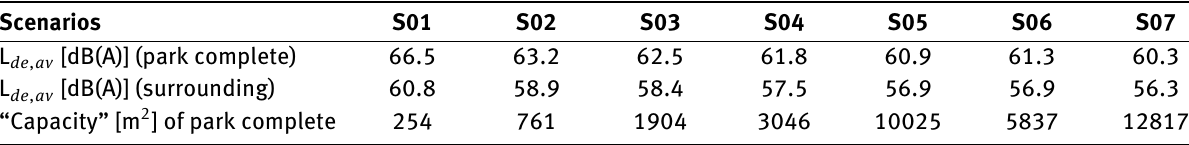
Table 5: L de , av average values in the park (complete) and the park surrounding specified for each of the scenarios. The corresponding ca- pacity values are also given.